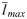
Time evolution of the F-actin distribution and the membrane profile for low polymerization rate.In this model, we have reduced l¯max to 30, half its default value (see Table 1). This corresponds to a reduction of 50% in the polymerization rate. The actin network cannot effectively invaginate the membrane.